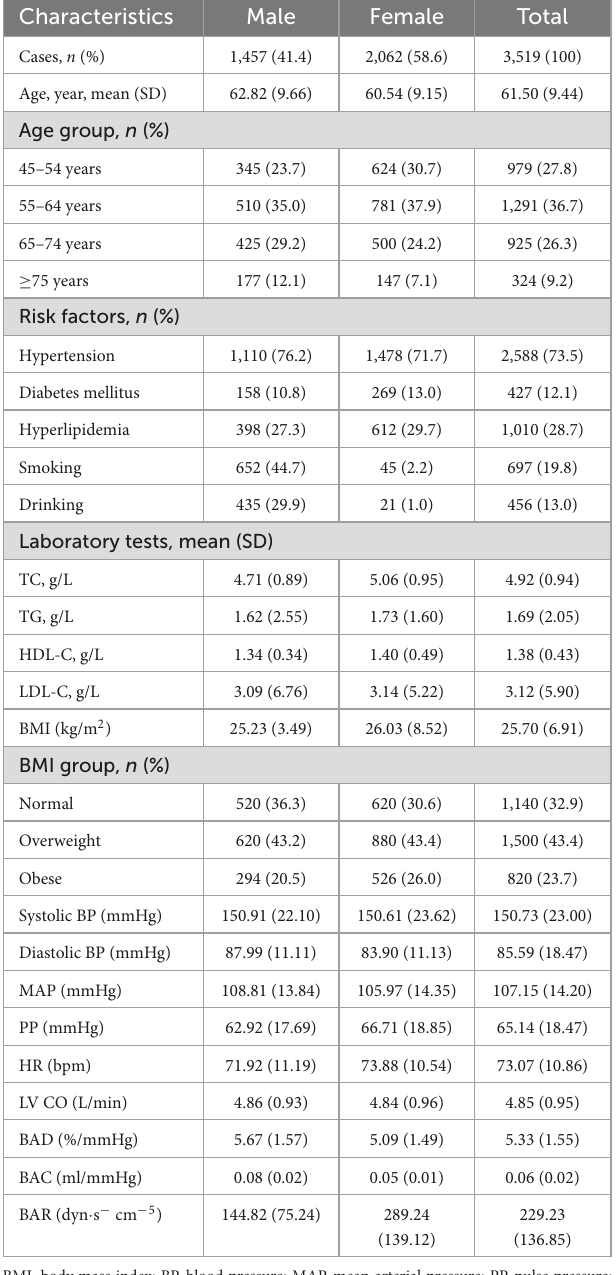
TABLE 1 Baseline characteristics of male and female. Characteristics